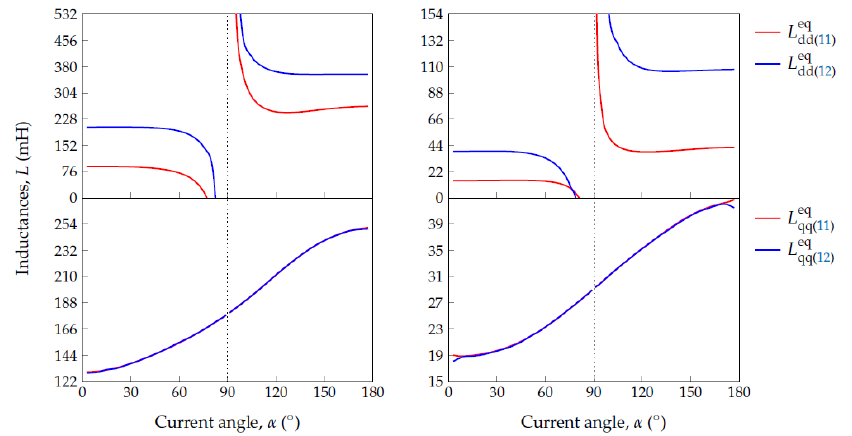
Figure 10. WF-FMM equivalent inductance characteristics of ( left ) WF-FSM and ( right ) DC-VRM at rated currents (phase and field) and different operating points defined by the current